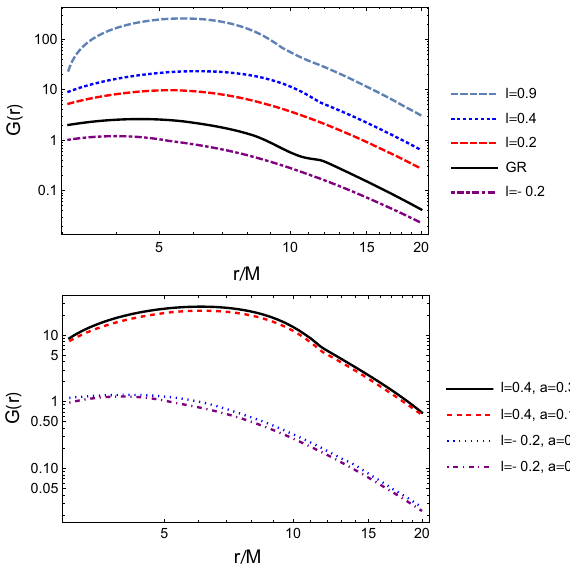
Fig. 3 Plot of G ( r ) against r / M for a disk with a temperature T ∝ 2 R ph / r . Upper graph: different values of l with fixed value 0 . 5 of the spin parameter a . Lower graph: different values of the spin parameter a with l < 0 and l > 0